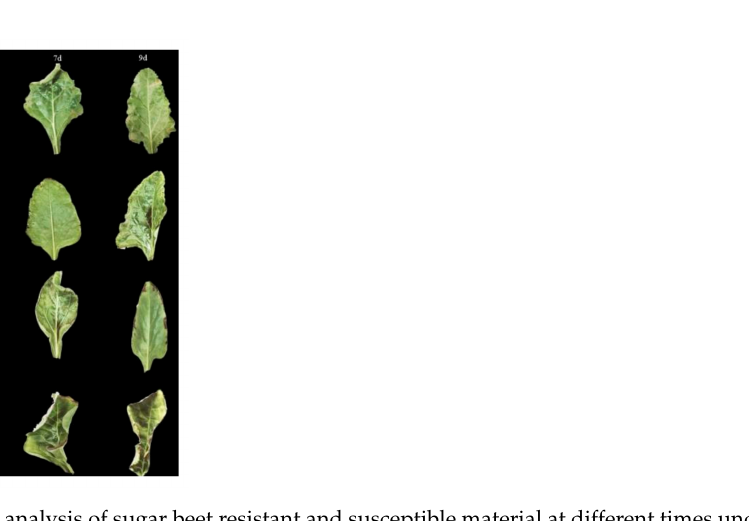
Figure 7. Phenotypic analysis of sugar beet resistant and susceptible material at different times under different spore concentrations of C. beticola .